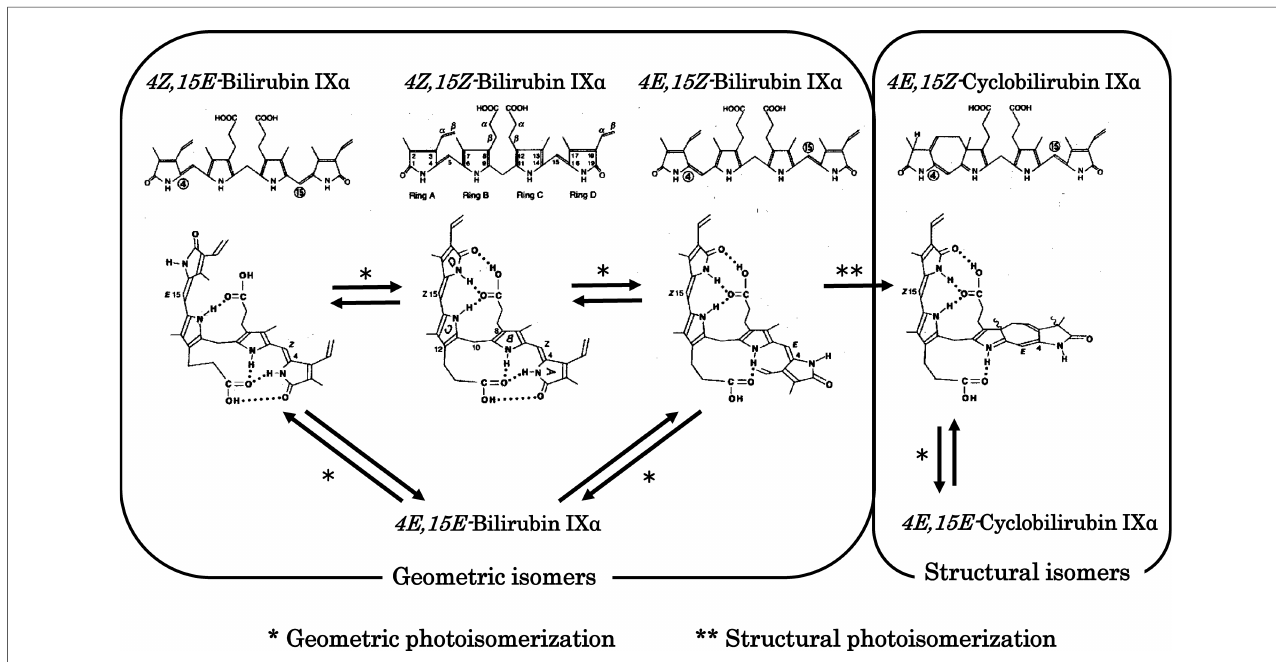
FIGURE 2 Photochemical changes in 4Z,15Z -bilirubin IX α . Photochemical changes in 4Z,15Z -bilirubin IX α in bilirubin – human serum albumin are predominantly to 4Z,15E -bilirubin IX α and cyclobilirubin IX α (lumirubin). Storage route of bilirubin: 4Z,15E -Bilirubin IX α is excreted from the liver into the bile and then may reconvert to 4Z,15Z -bilirubin IX α in the digestive tract to be retained in the body through the enterohepatic circulation. Elimination route of bilirubin: 4E,15Z -Cyclobilirubin IX α (Z-lumirubin) and 4E,15E -cyclobilirubin IX α (E-lumirubin) are the most important pathways affecting the clinical ef fi cacy of phototherapy because they polymerize into a dark brown substance that causes bronze baby syndrome, an adverse reaction to phototherapy, and is ultimately excreted from the